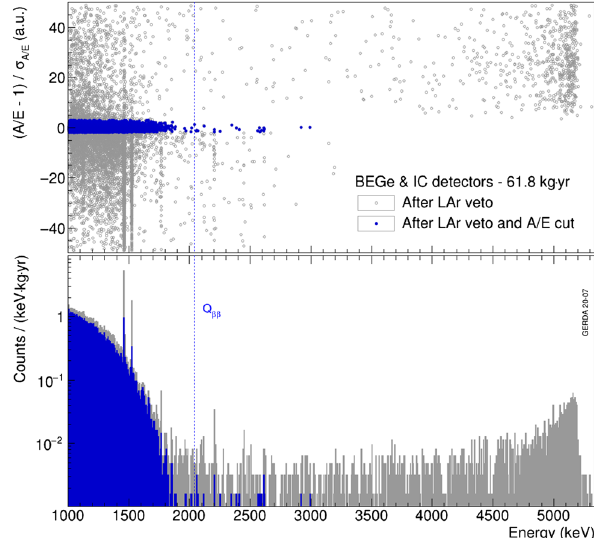
Fig. 10 Energy distributions of all Gerda Phase II physics data from the BEGe and IC detectors before (grey) and after (blue) the A / E cut. The position of Q ββ is indicated. The prominent 40 K and 42 K lines are located at 1461 keV and 1525 keV,